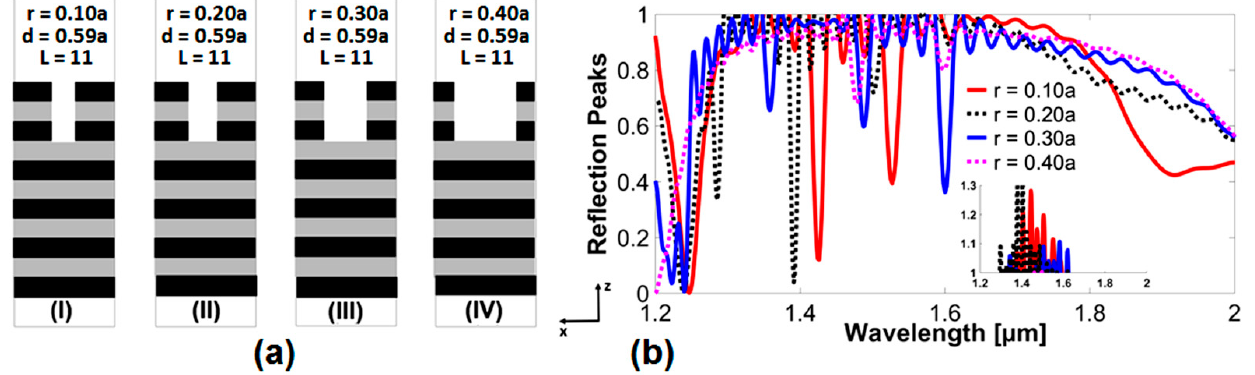
Figure 5. ( a ) 2D unit model with hole depth limited to third DBR layer and r varying as (I) 0.1 a , (II) 0.2 a , (III) 0.3 a , and (IV) 0.4 a . ( b ) Reflection spectra of the structure for r = 0.1 a , 0.2 a , 0.3 a , and 0.4 a .